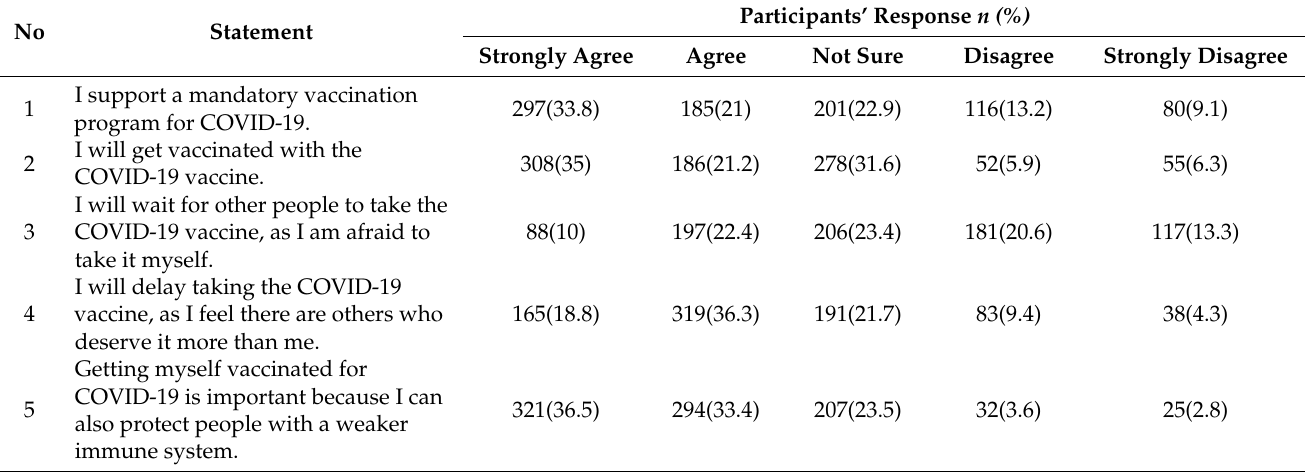
Table 4. Intention to vaccinate.